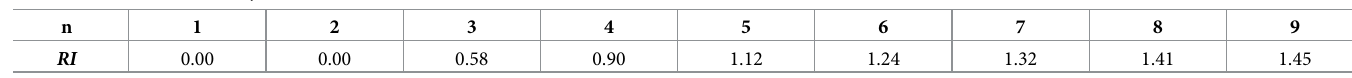
Table 8. Random consistency index.